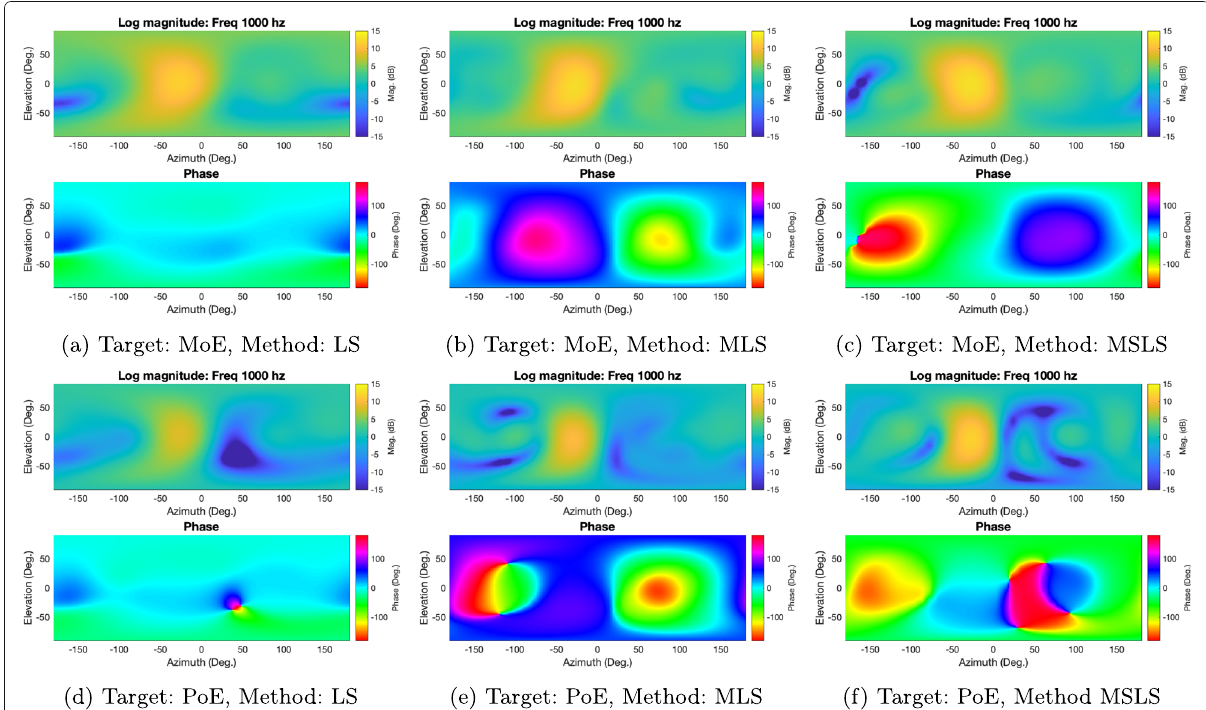
Fig.7 Beampatterns are shown for far-field beamformers fitted to target MoE and PoE targets specified in Fig. 3 using LS, MLS, and MSLS methods. LS over-fits to a 0 radian phase response. MLS achieves a closer fit to the magnitude target. MSLS over-fits to areas where the magnitude target is large